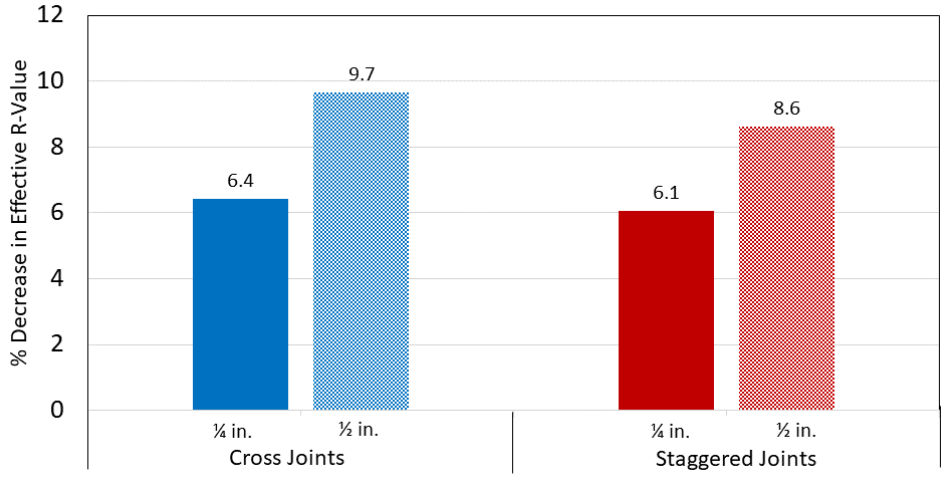
Figure 8. Cross vs. Staggered Joint: % Decrease in Effective R-Value.